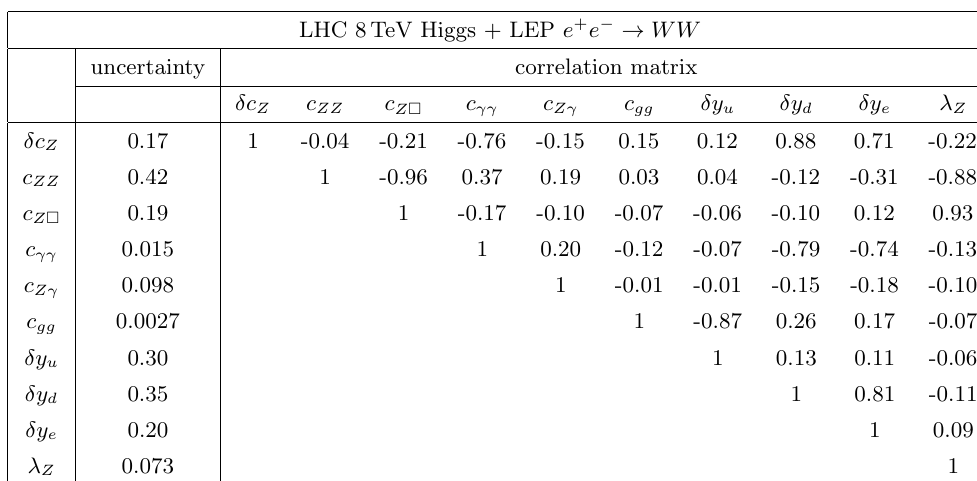
measurements. Flavor universality is imposed. (cid:0) ! WW (cid:14)y t , (cid:14) d (cid:14)y b , (cid:14)y e (cid:14)y (cid:28) . For consistency ! ! !